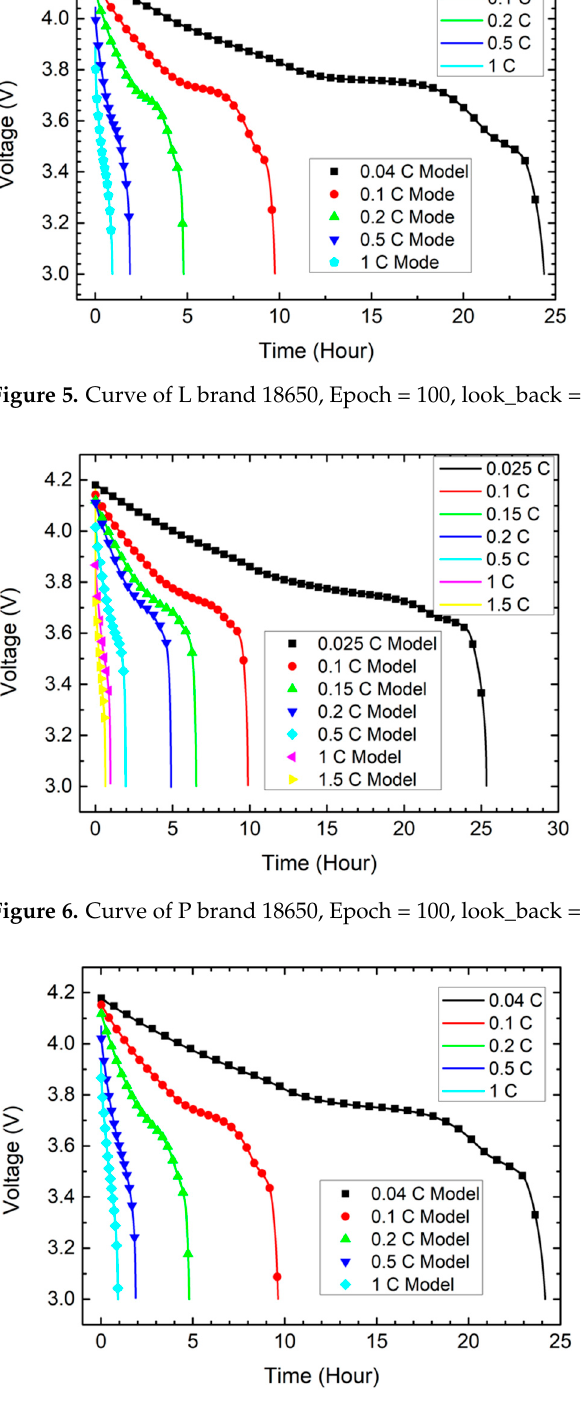
Table 2. Results of MLP, Epoch = 100, look_back = 10.